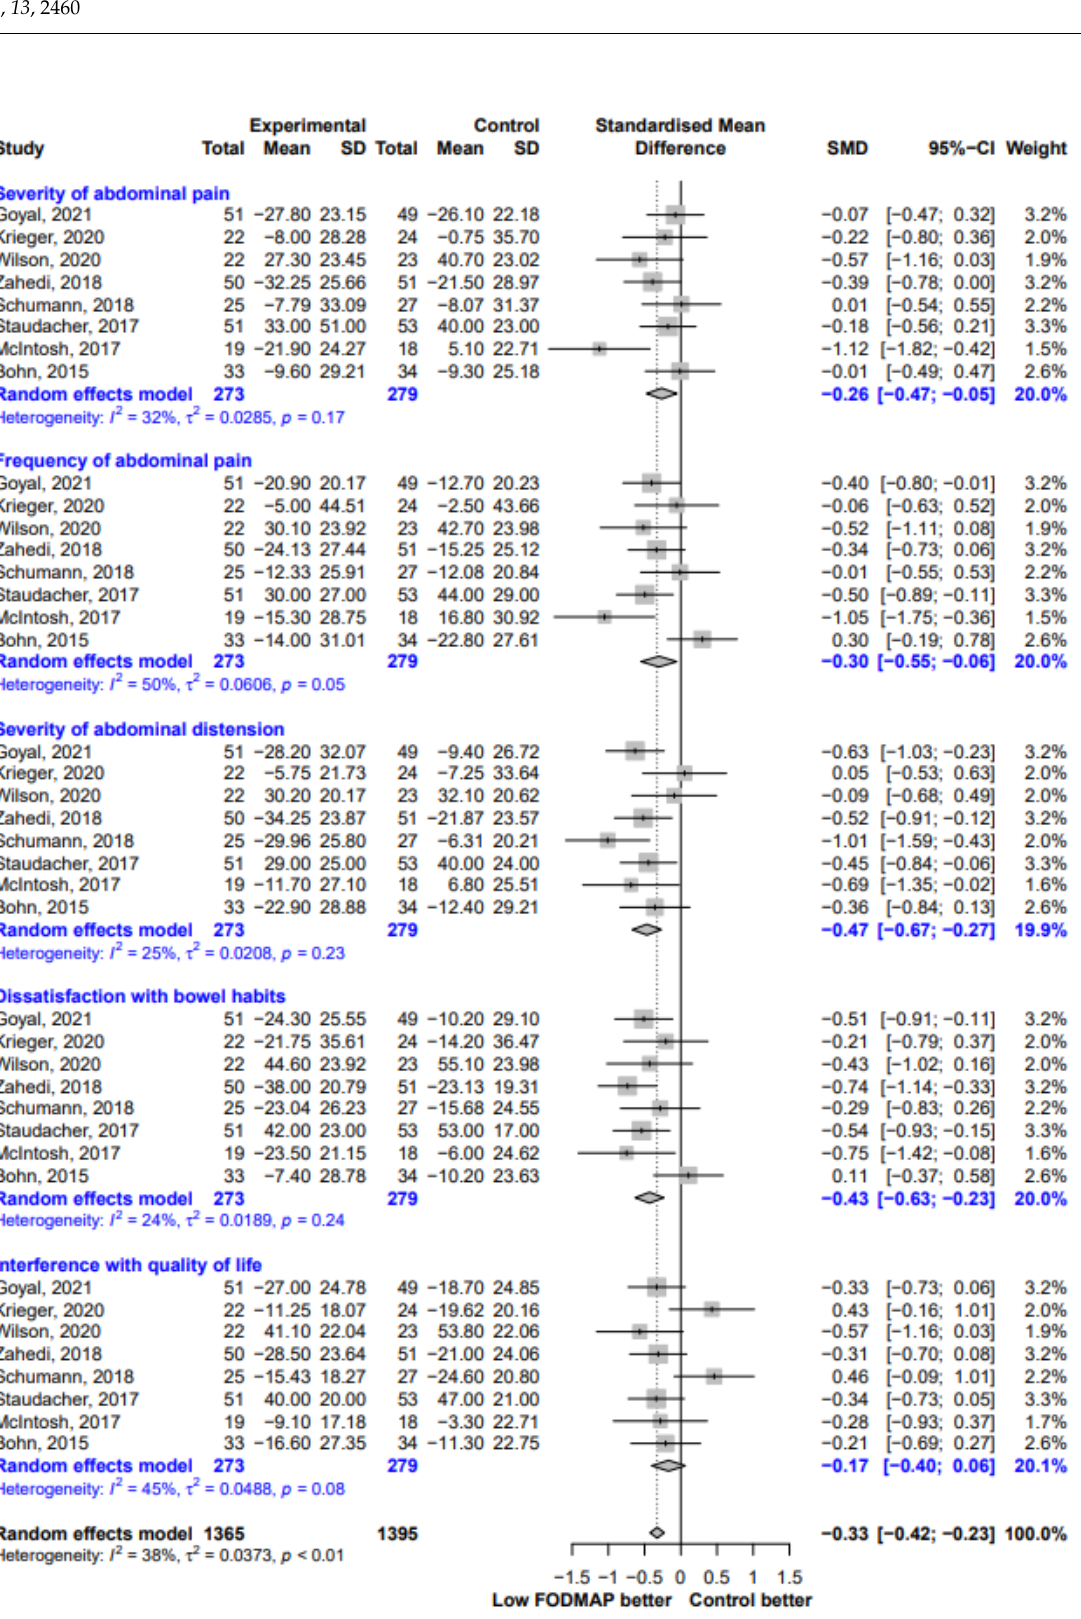
Figure 5. Forest plot showing standardized mean differences for five IBS ‐ SSS subscale scores. SD, standard deviation; SMD, standardized mean difference; CI, confidence interval .